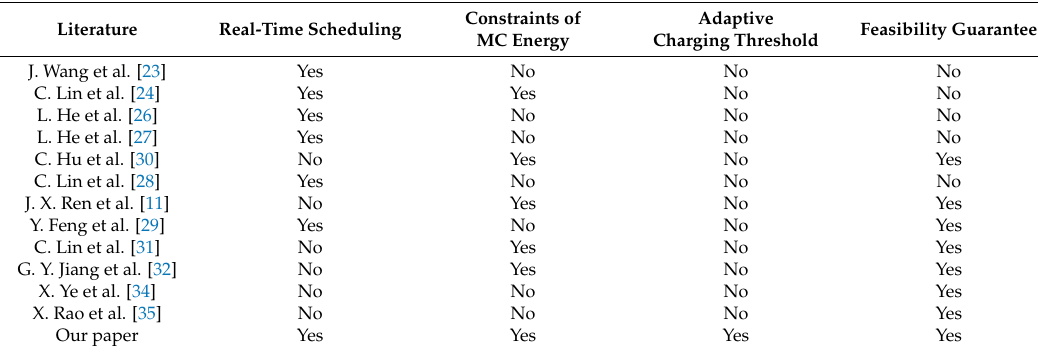
Table 1. The summary of related